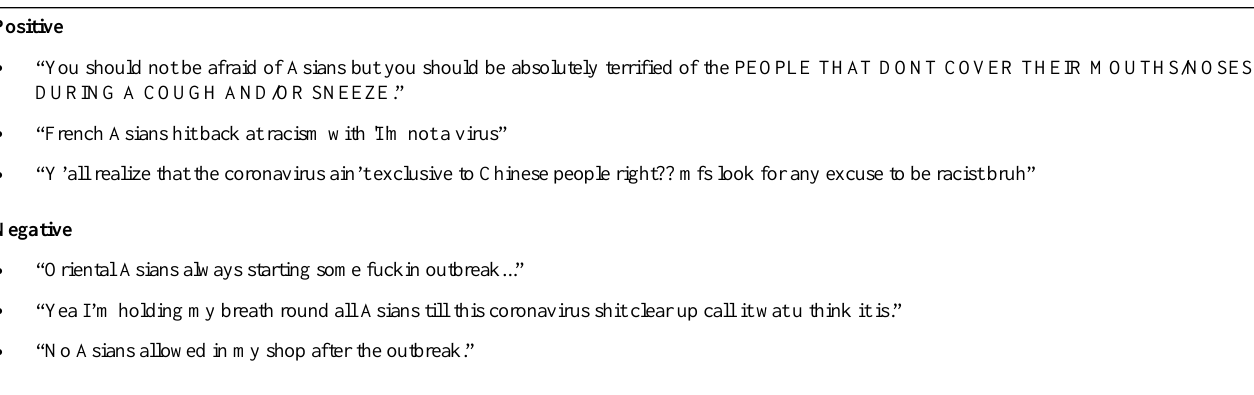
Textbox 2. Sample tweets showing positive or negative sentiments toward Asians.